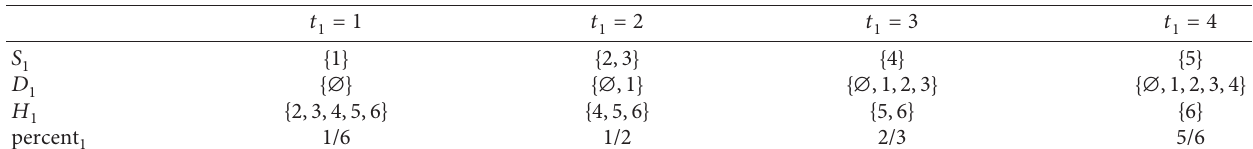
Figure 10: Example of risk spreading from node 1 with domino spreading algorithm: (a) spreading status with t � 1; (b) spreading status with t � 2; (c) spreading status with t � 3; (d) spreading status with t � 4. Table 8: Risk spreading process from node 1.